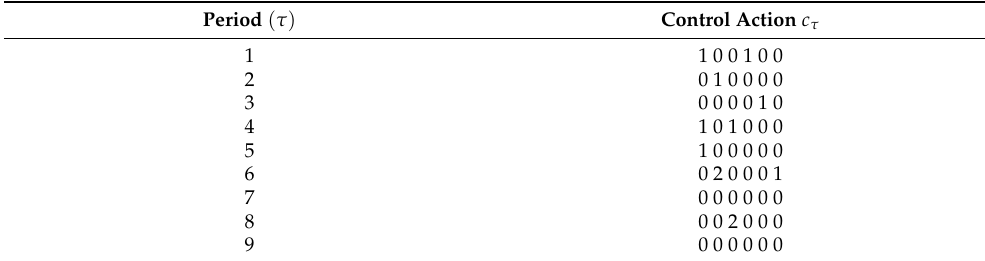
Table 7. The sequence of control